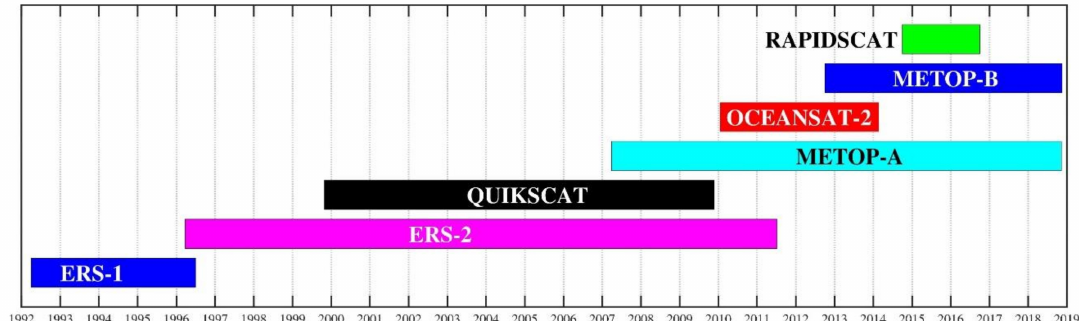
Figure 1. Scatterometers in the Ribal and Young [8] database and the duration of each